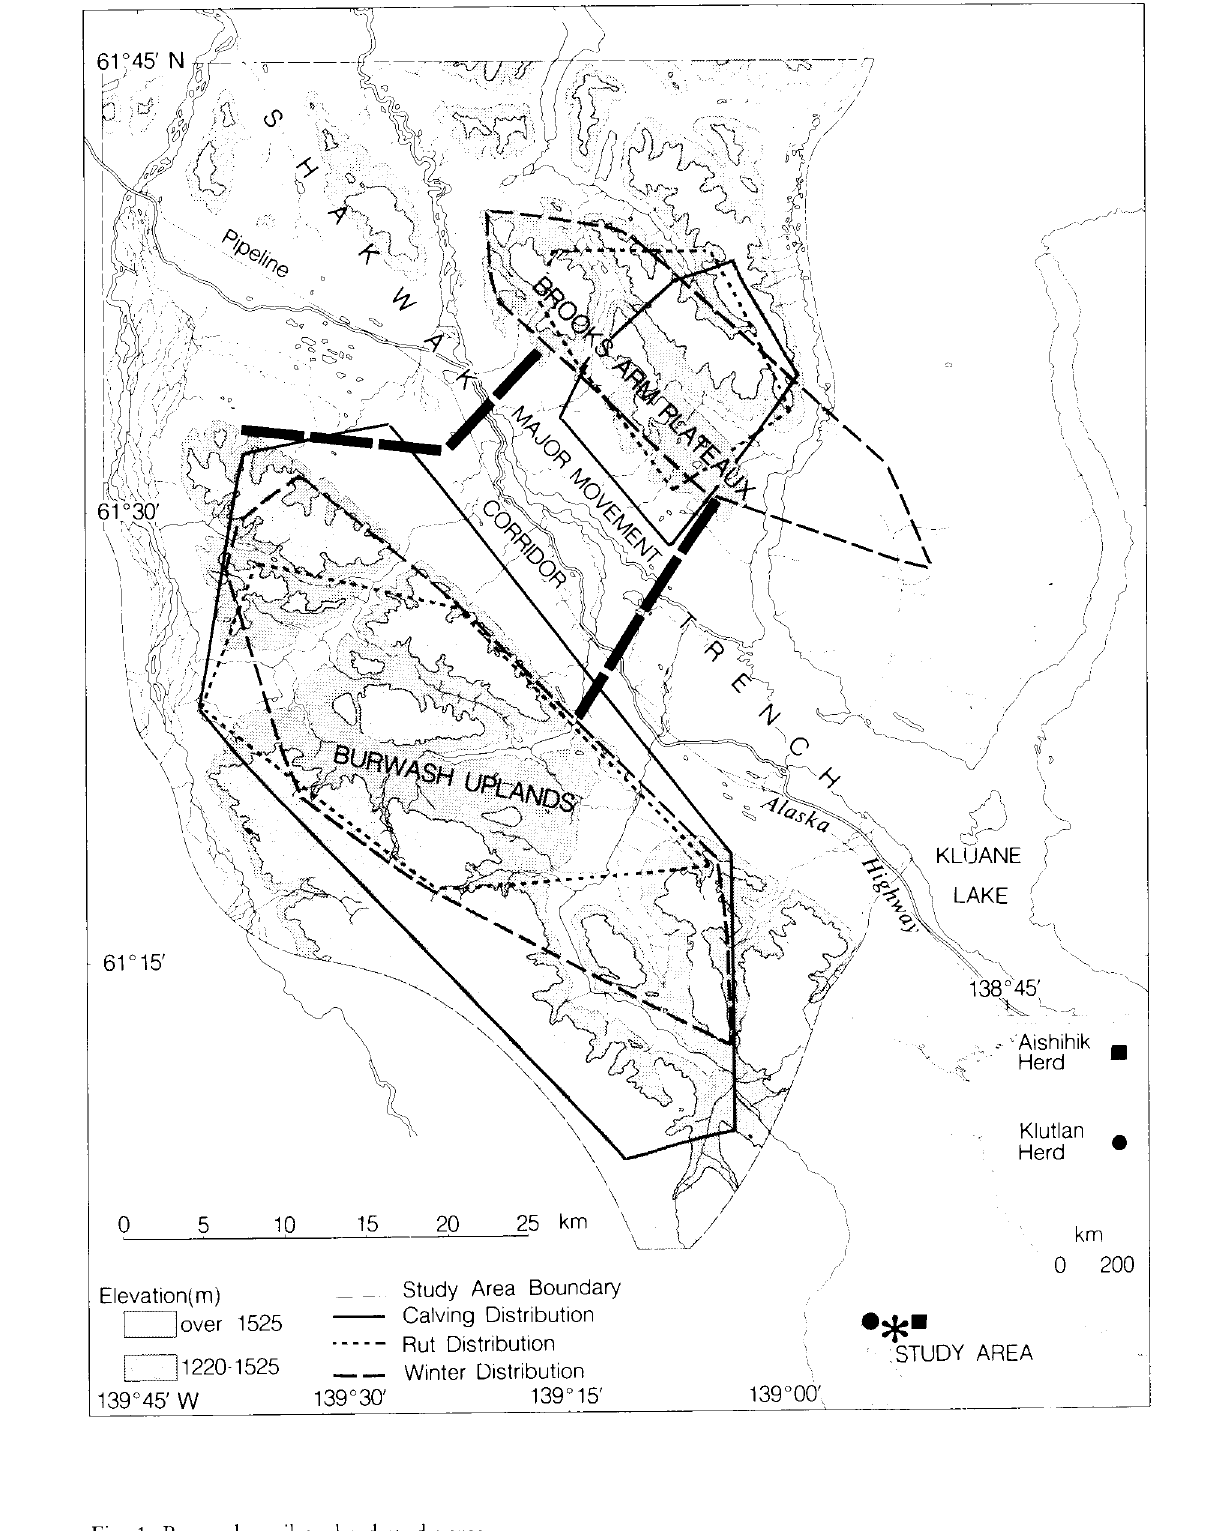
Fig. 1. Burwash caribou herd study